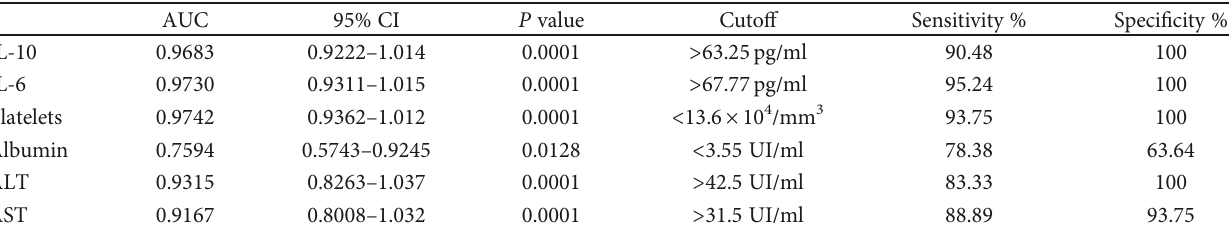
Figure 3: Correlation analysis between socs1 , socs3 , and IL-10. Spearman ’ s and Pearson ’ s correlation coe ffi cients were calculated to identify the association between IL-10 concentration and socs1 expression (a) and between socs3 and socs1 expression levels (b). Table 2: Potential biomarkers to discriminate healthy from dengue